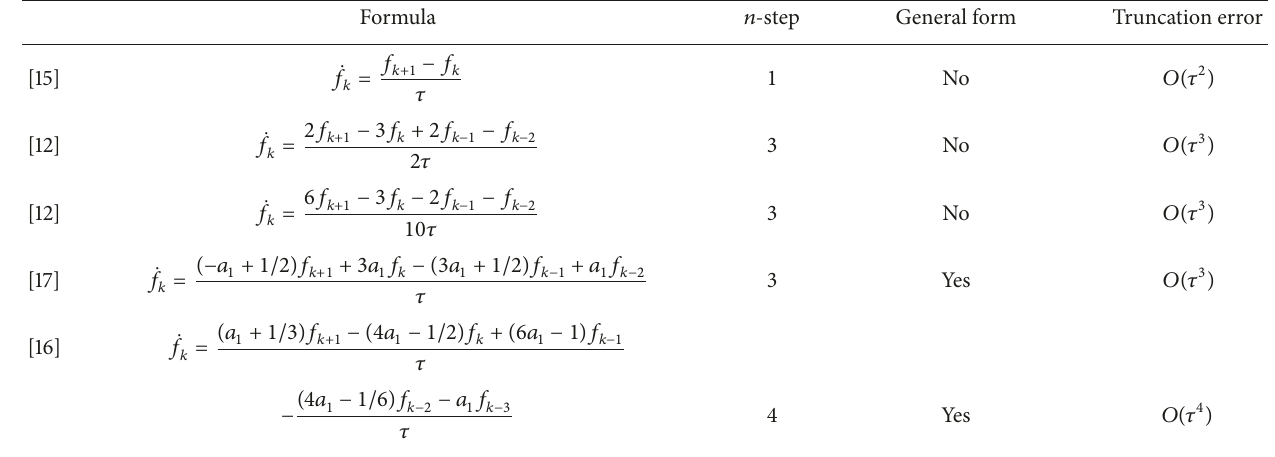
Table 1: ZeaD formulas used in [12,